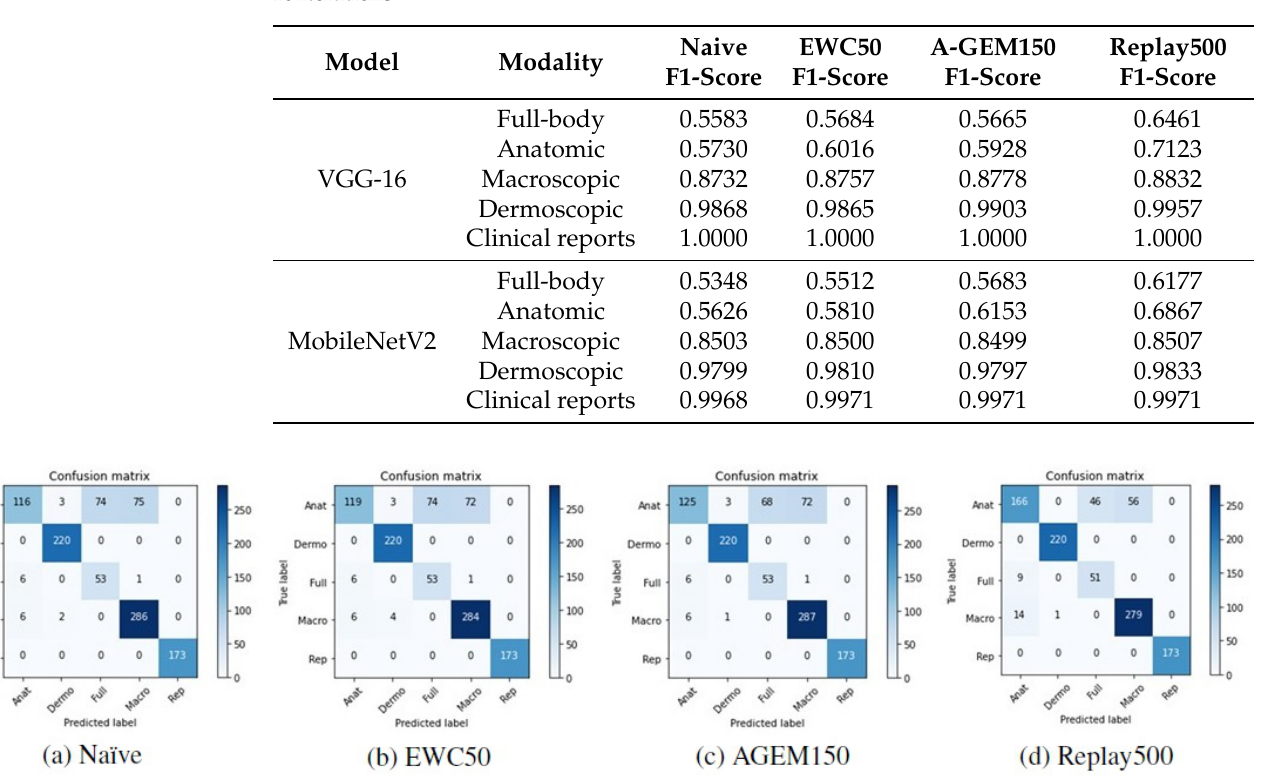
Table 6. Results of Task A after the incremental training has been performed. Results averaged over 10 iterations.